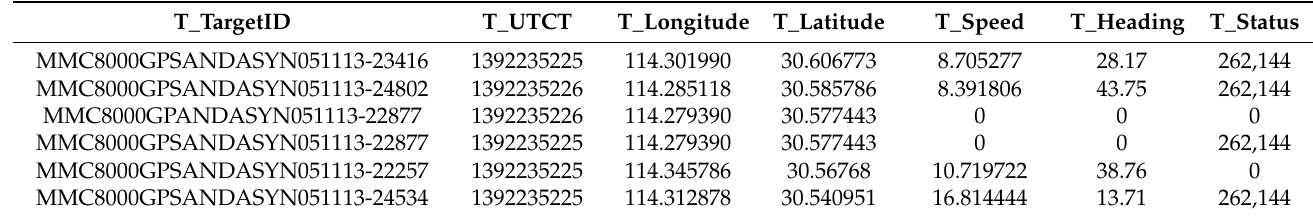
Table 5. Common taxi trajectory data fragments.